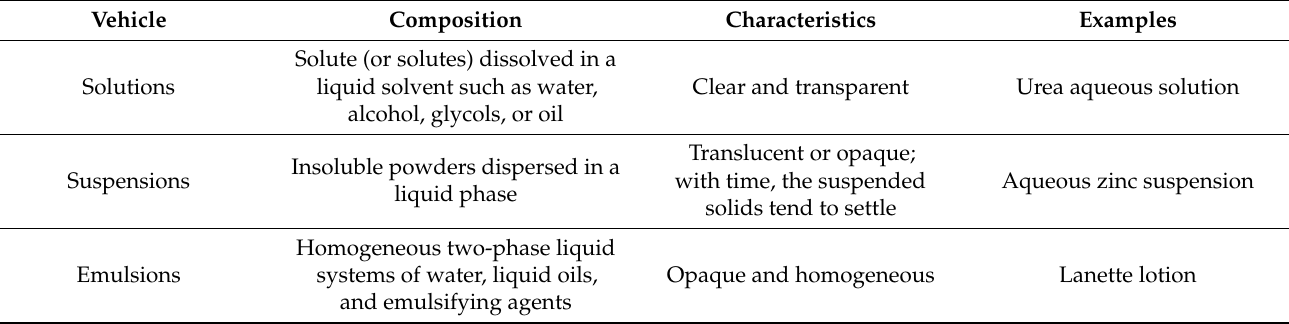
Table 1. Characteristics of liquid vehicles